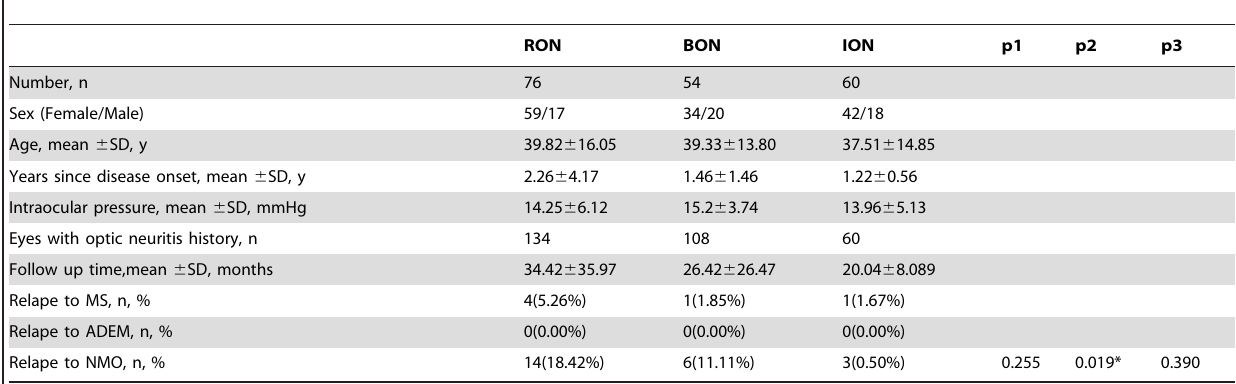
Table 1. Epidemiologic and Disease Characteristics of Patients with three types of